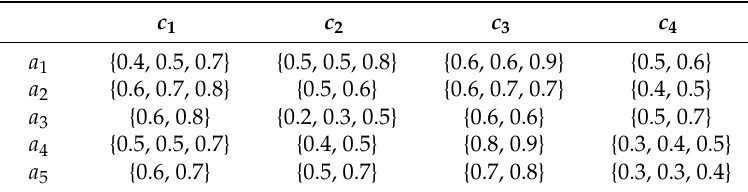
Table 1. Multi-hesitant fuzzy decision